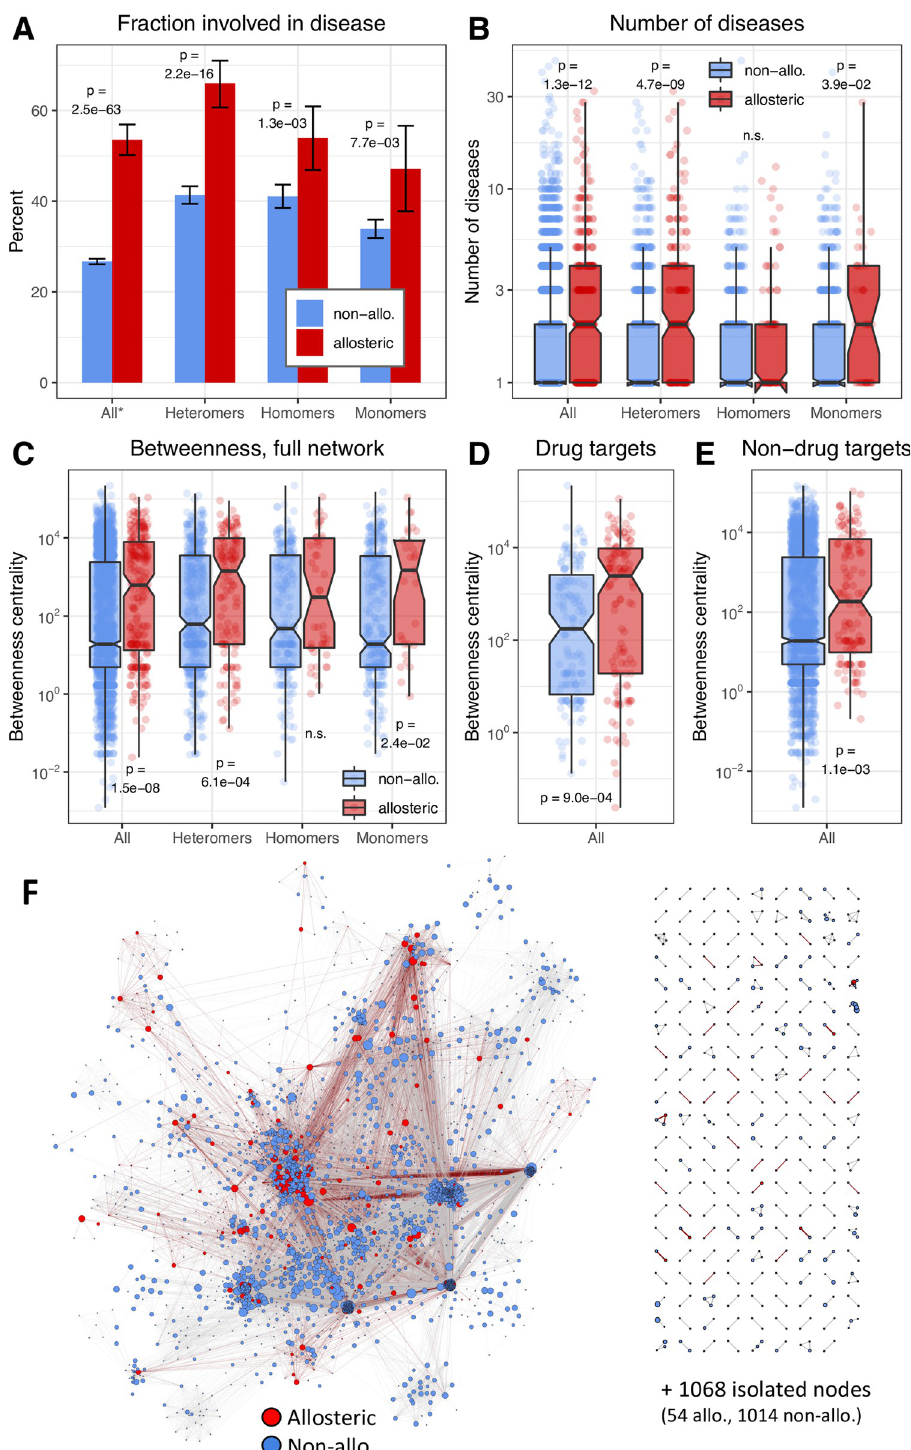
Fig 2. Allosteric proteins are overrepresented in disease, and are central in disease-protein networks. A) Allosteric proteins are significantly more frequently involved in disease than non-allosteric proteins, irrespectively of their quaternary structure. * In the ‘All’ category the number of non-allosteric proteins was defined as human SwissProt proteins minus all human allosteric proteins. Note that the ‘All’ category includes also the proteins where quaternary structure is not known. B) Allosteric proteins (except homomers) are involved in significantly more diseases than